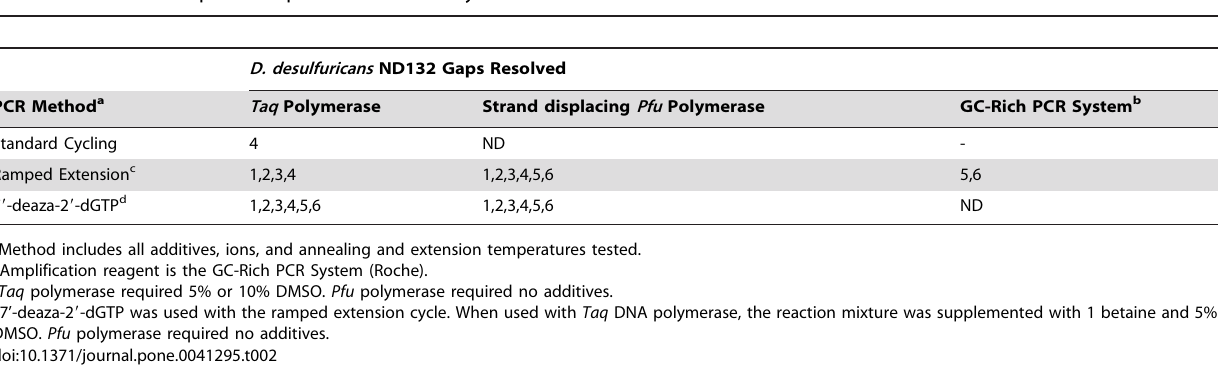
Table 2. ND132 Template Amplification